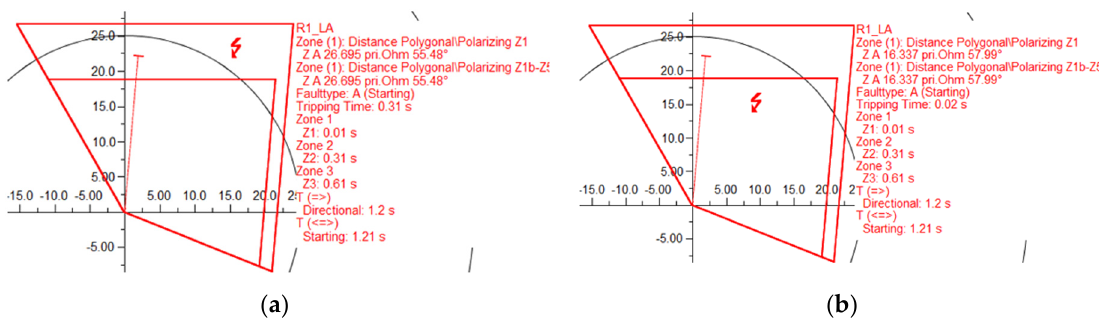
Figure 17. R-X plot for an SLG fault at 80%, with ( a ) both line A and B connected and fault resistance of 18 Ω with com- pensation ( b ) line B disconnected.